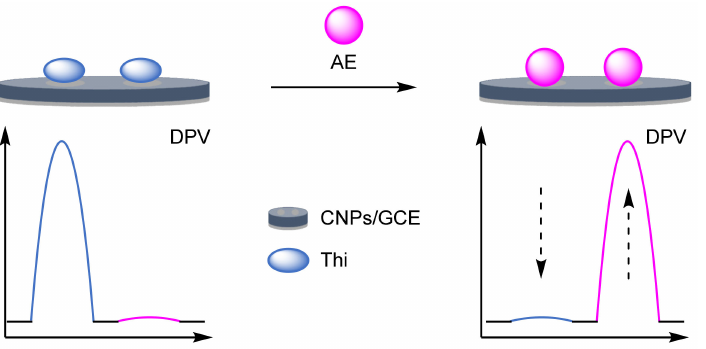
Figure 41. Schematic representation of a molecular imprinted polymer-based host–guest displace- ment assay for the detection of aloe-emodin